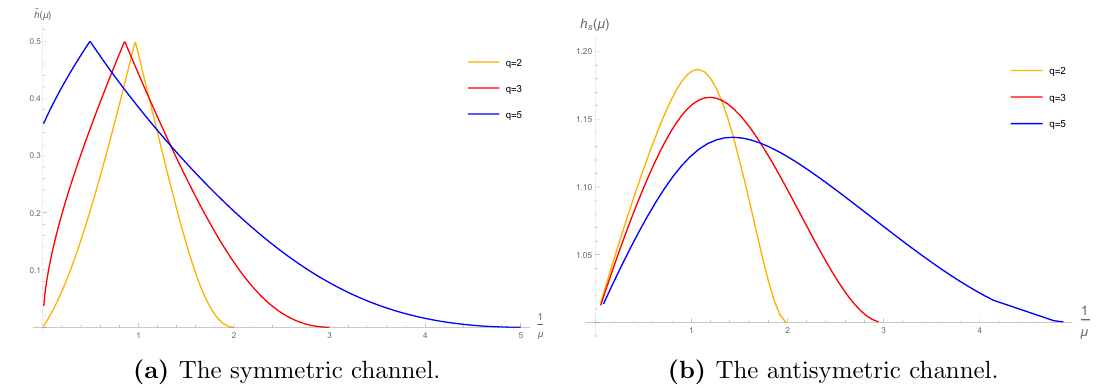
Figure 4. The lowest dimensions of the scalar operators in the four point function. The plots illustrate how does the dimension change as a function of (cid:22) . The kinks on each curve in (cid:12)gure 4a is the crossover point of the operator and its \shadow" operator due to the symmetry h $ 1 (cid:0) h and ~ h $ 1 (cid:0) ~ h